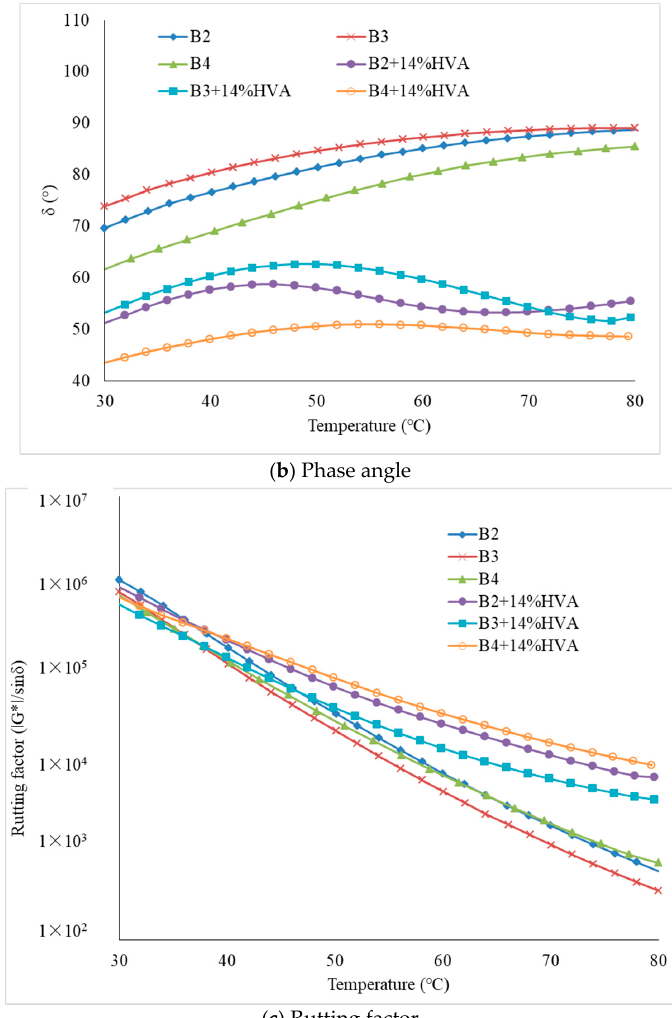
Figure 6. Temperature sweep test results.